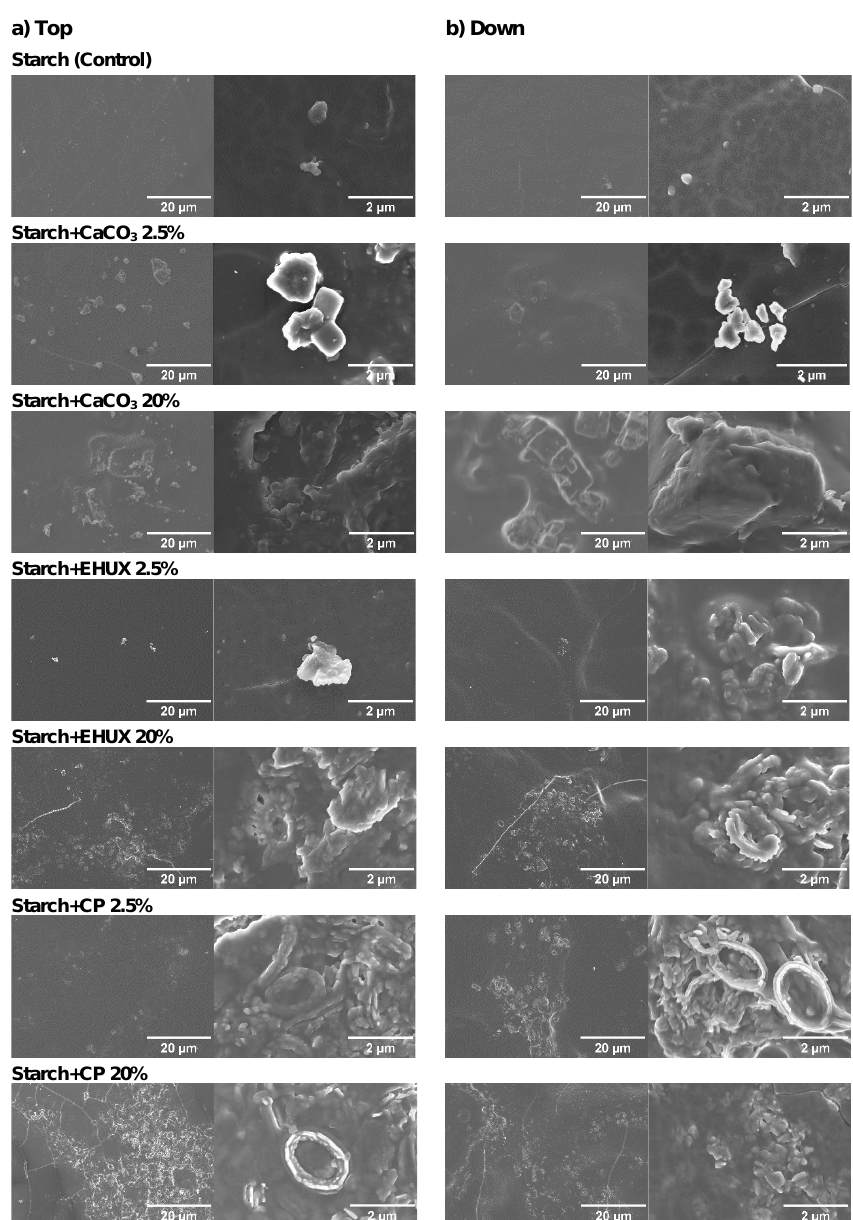
Figure 2. SEM micrographs of starch films (control) and starch-based films containing 2.5% and 20% of commercial CaCO 3 , E. huxleyi (EHUX) or C. pseudoroscoffensis (CP): ( a ) Top surface images and ( b ) Down surface images.